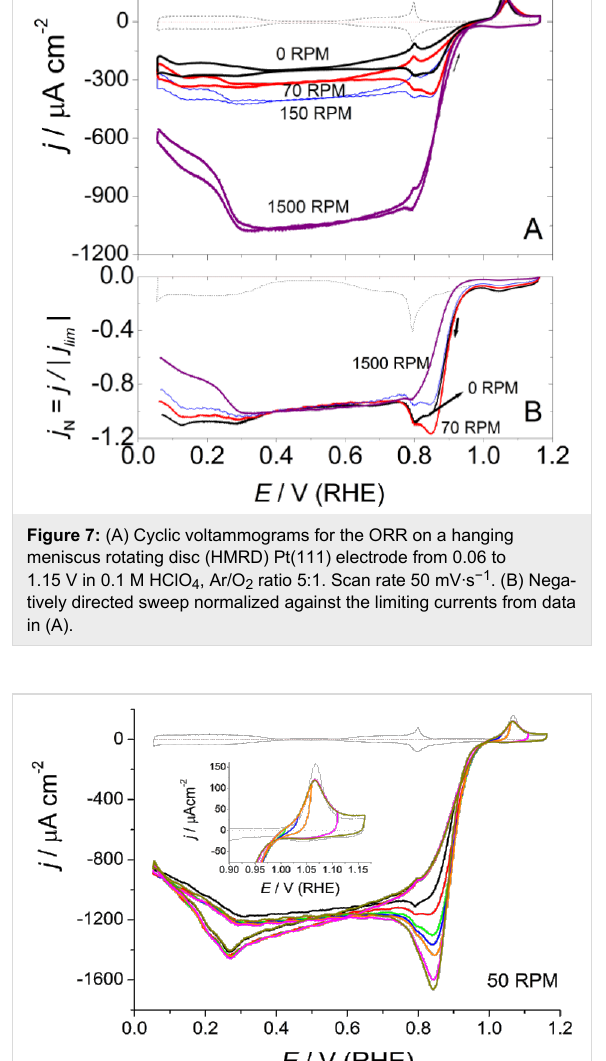
currents are normalized to j lim , it can be seen that this high potential current contribution progressively disappears as ω increases (Figure 7B). This would be compatible with the for- mation of a soluble intermediate species in the high potential region the concentration of which at the interface vanishes as ω increases [18]. The elimination of this soluble intermediate, however, is not very fast, which suggests some interaction with the surface. We can speculate that this interaction could likely take place through the water network, because of the necessary similar molecular composition of this intermediate and water, which would enable the formation of hydrogen